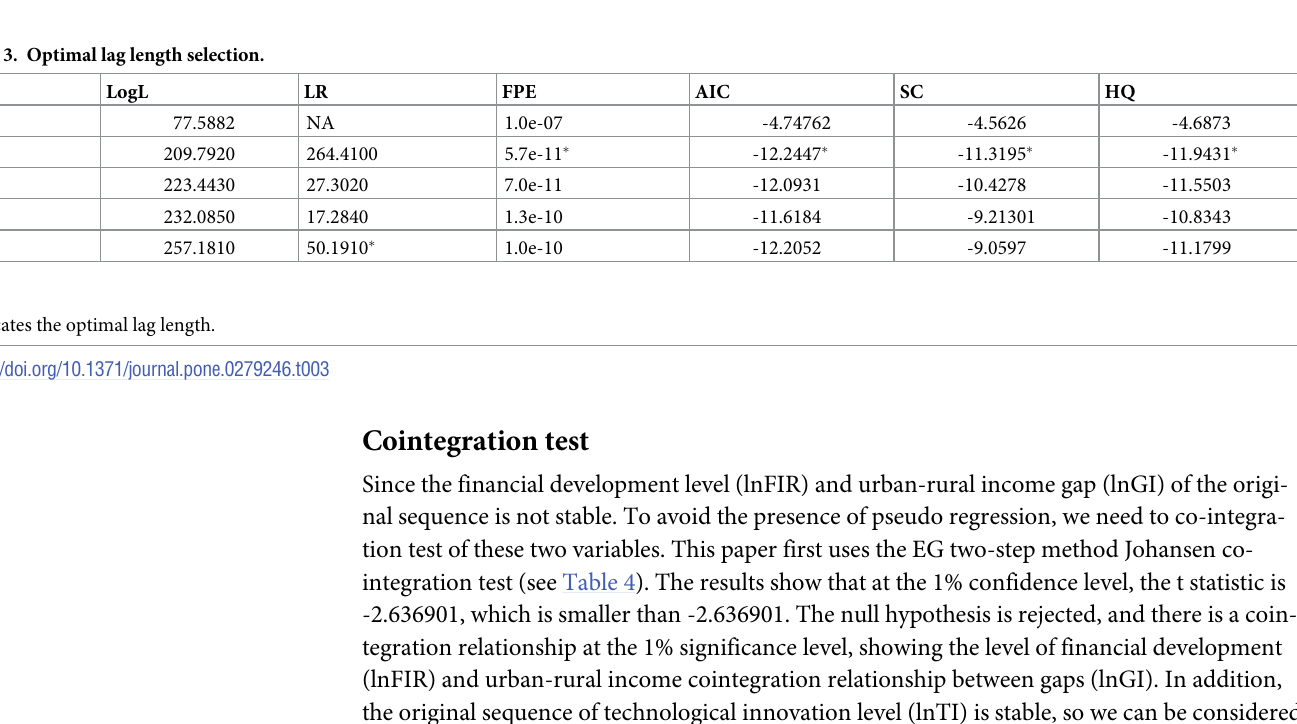
represents rejection of the null hypothesis at the 1% significance level.